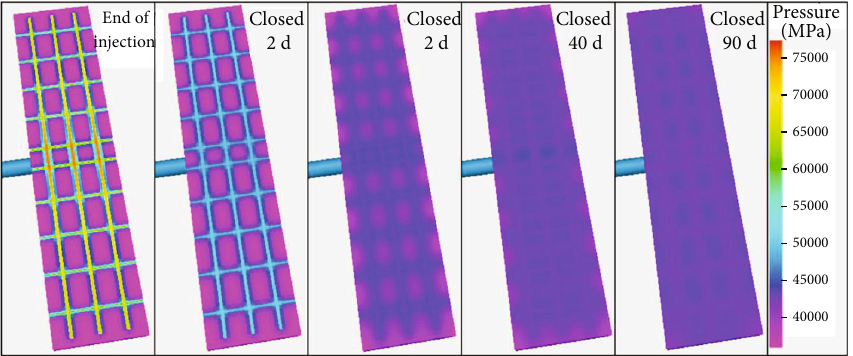
Figure 10: Simulation results of pressure propagation during fracturing shut-o ff